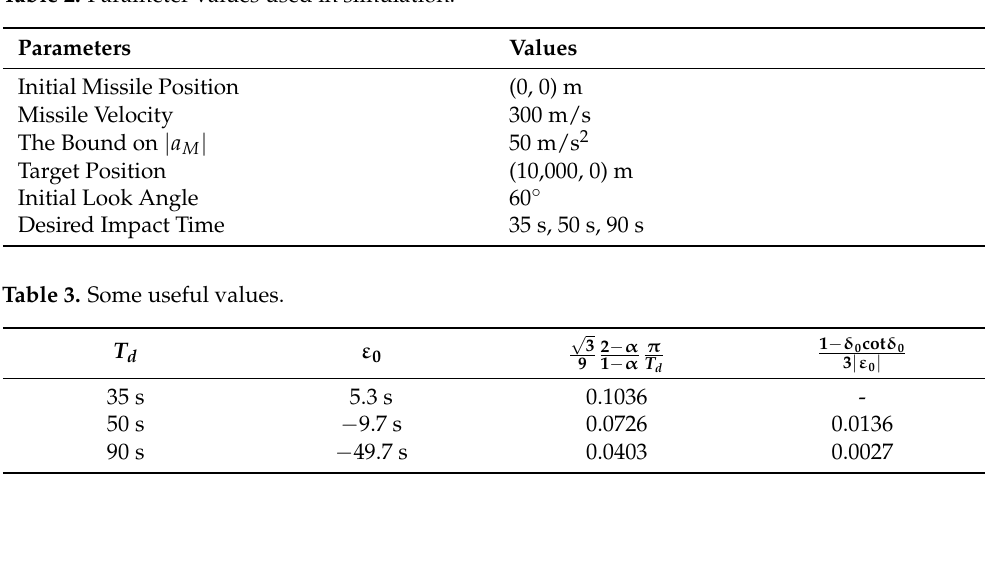
Table 2. Parameter values used in simulation.